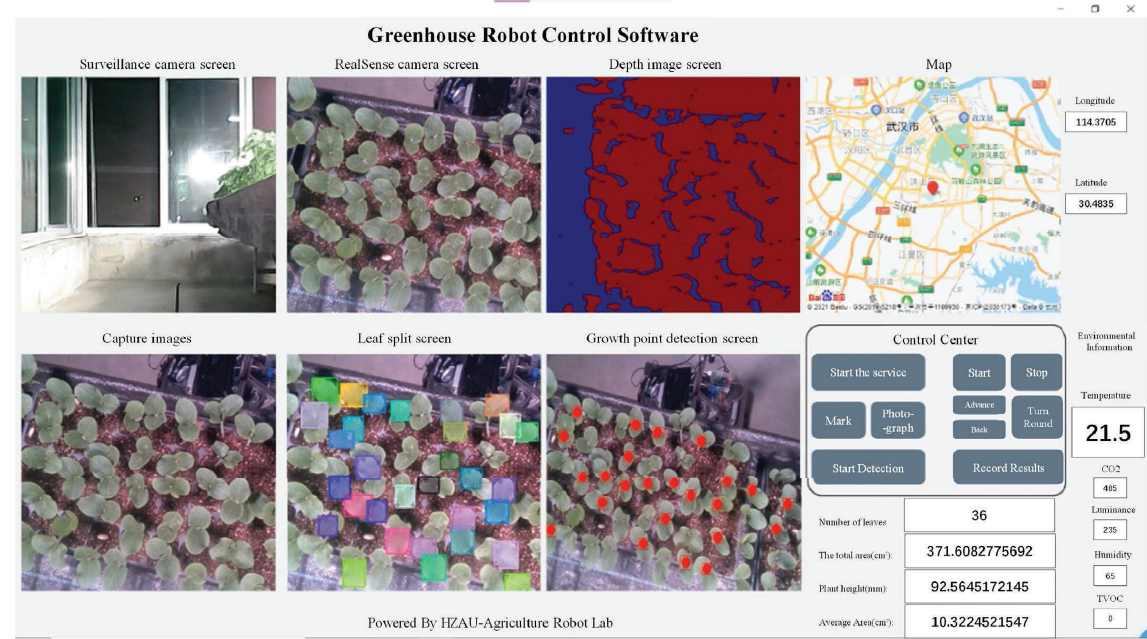
Figure 12: Host computer software